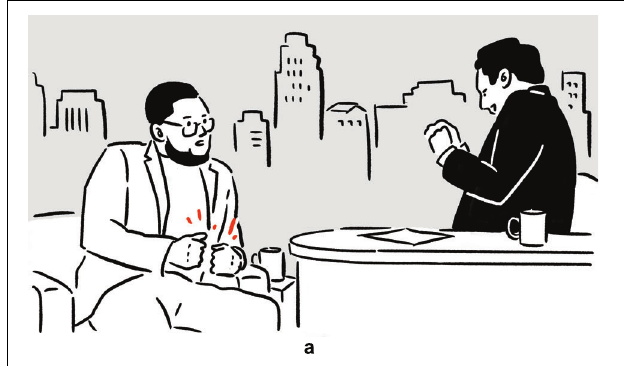
FIGURE 14 | Depiction in